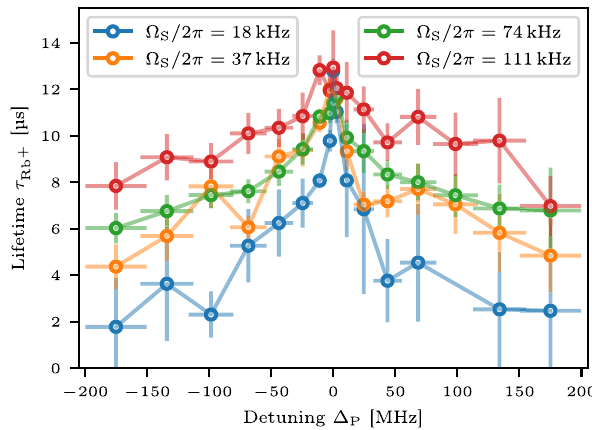
Fig. 5 Lifetime τ Rb þ of the Rb + ionization channel. With increasing detuning Δ P the lifetime drops. Increasing the Rabi frequency Ω S and thus increasing the seed atom number for a fi xed detuning leads to a longer lifetime, indicating a larger fraction of delocalized states. The lifetimes are obtained numerically from the ion signal under the assumption of exponential decay of the Rb + channel of the time-resolved spectra (see Supplementary Note 3). Horizontal error bars re fl ect energy bin sizes for the evaluation. Lifetime errors are given by error propagation of the standard error of the